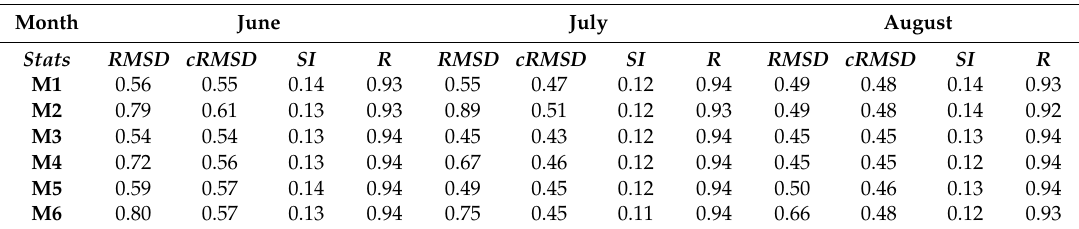
Table 4. Regional wave model performance compared with the co-located altimetry measurements Table